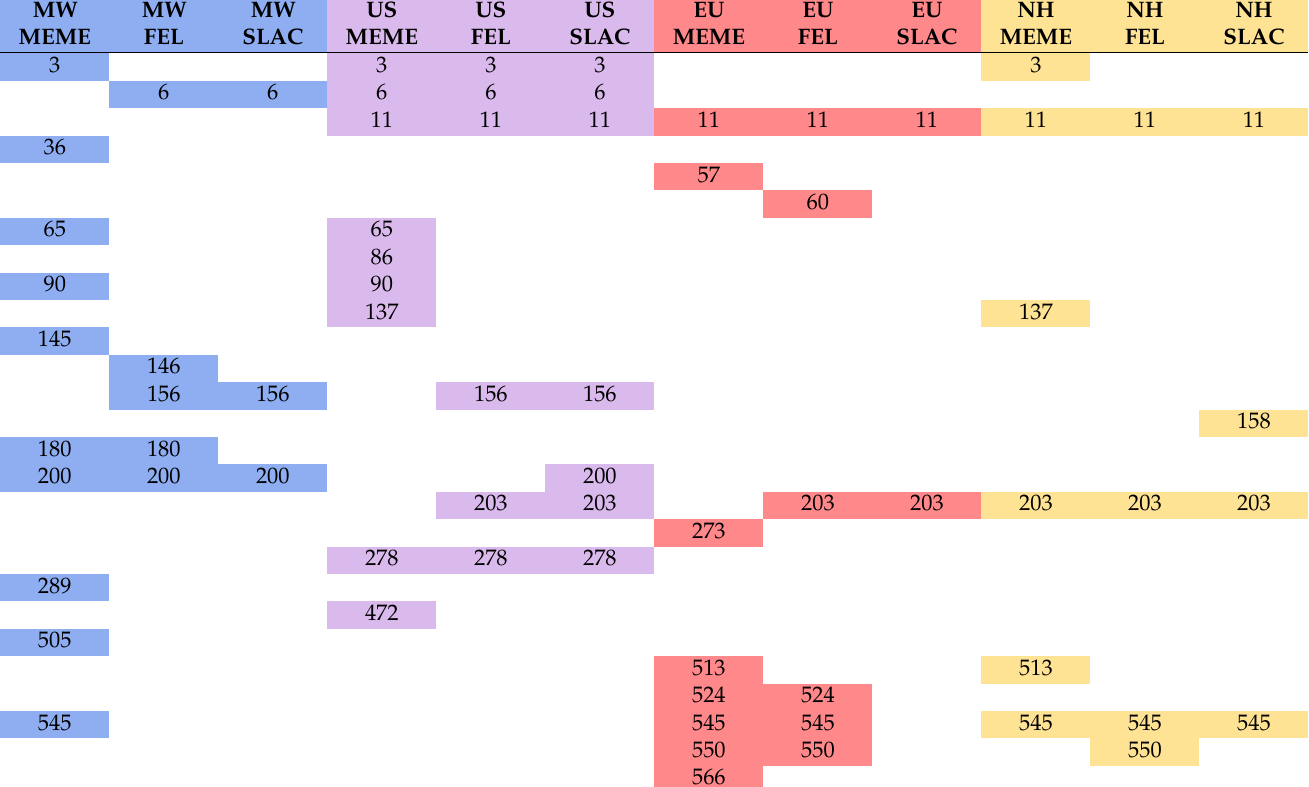
Table 2. Significant results from each HyPhy selection pressure algorithm by codon position, with the MW, US, EU, and NH datasets represented in blue, lavender, red, and yellow